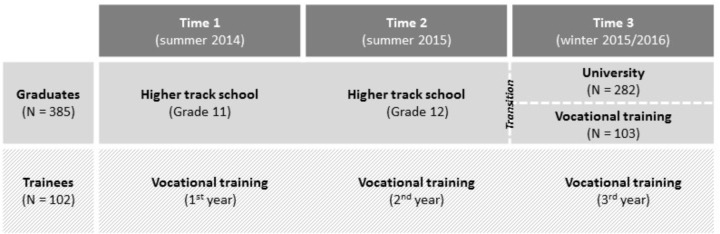
Educational development of the participants of BiKSplus[8-18].